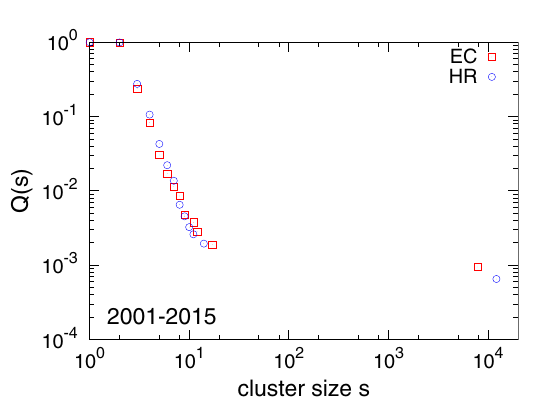
with exponents ν 1 as a 1